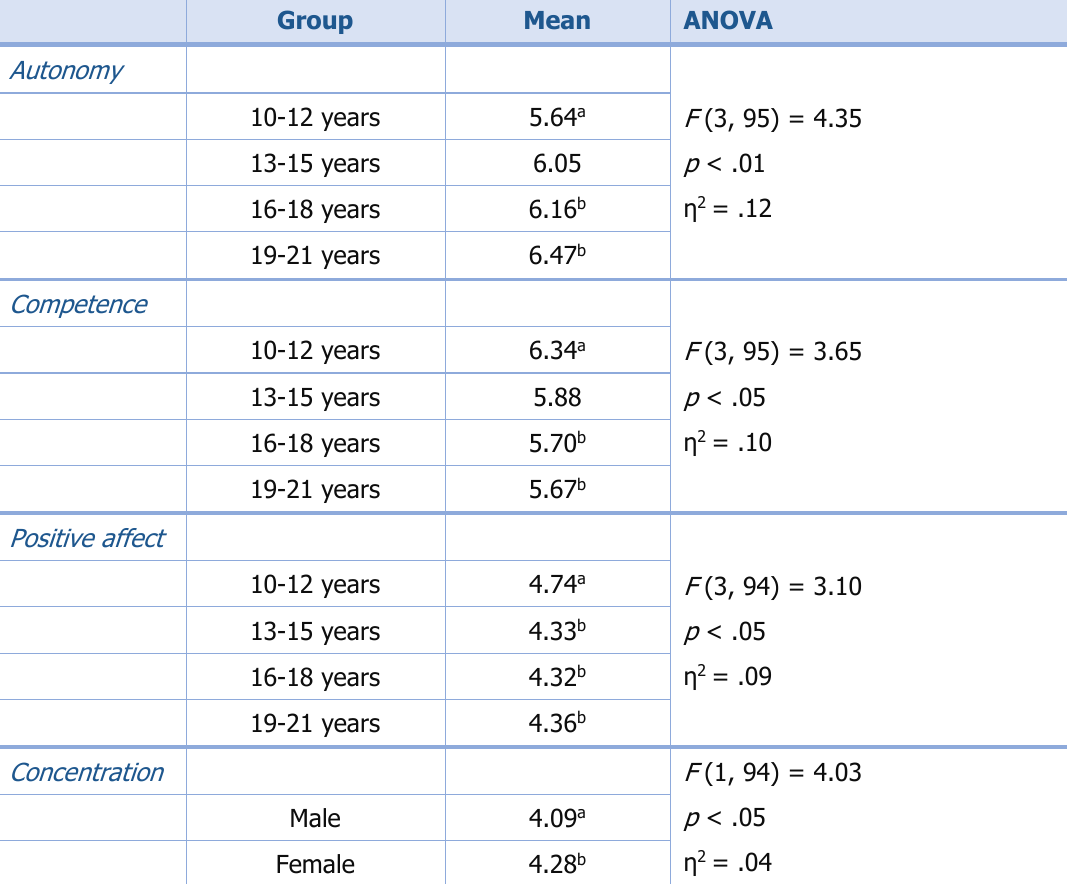
Table 2. Gender and Age Differences in Youth Development Outcomes: Main Effects